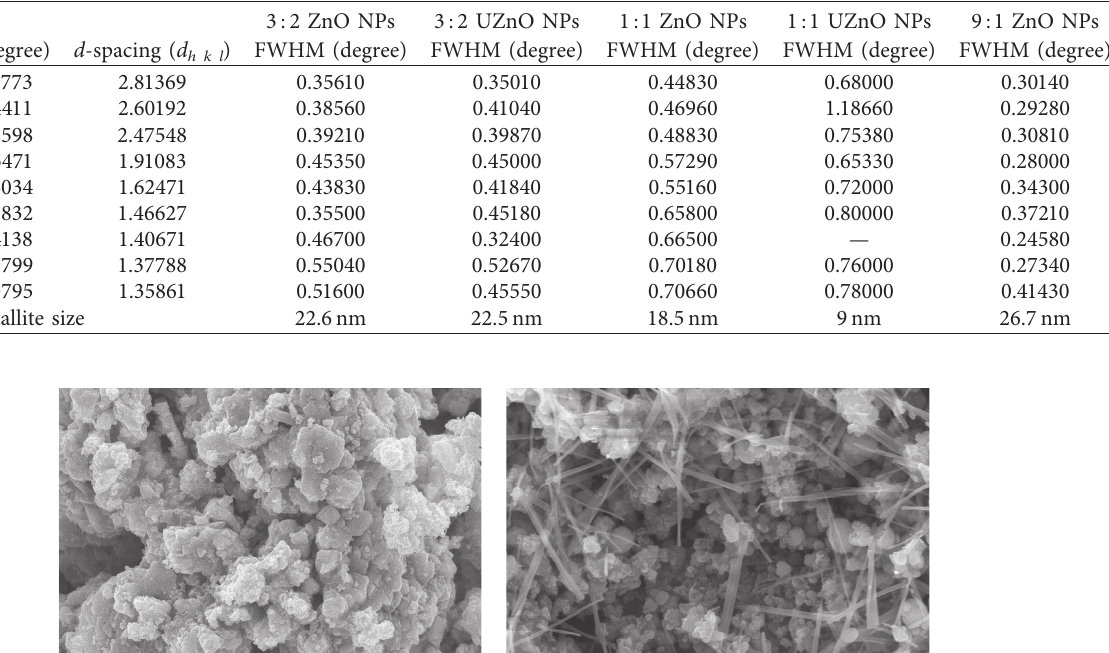
h k l ), and Miller indices of calcinated and